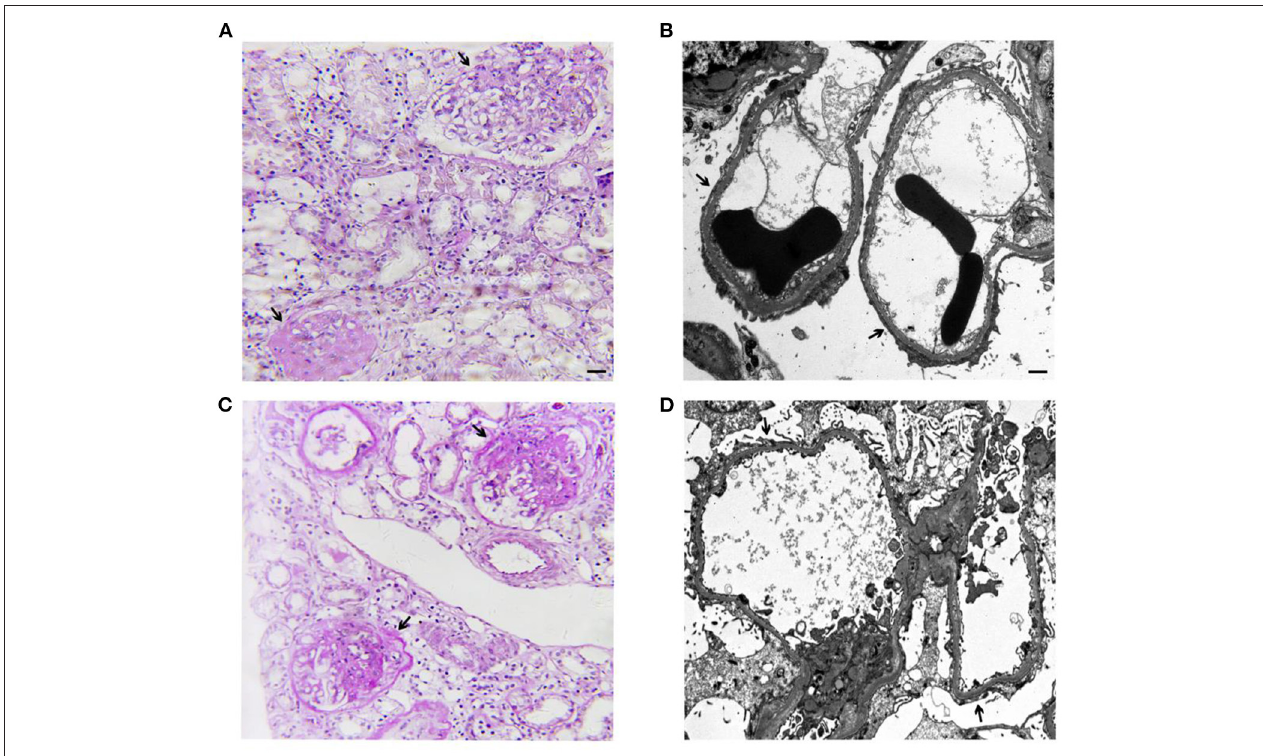
FIGURE 1 | Representative images of light microscopy and transmission electron microscopy (TEM) from the kidney biopsies of the elder sister at age 12 (A,B) and the younger brother at age 8 (C,D) . (A) Global or segmental glomerulosclerosis (arrow) in 23 of 38 glomeruli (Periodic Acid-Schiff staining. Scale bar: 50 µ m). Immunofluorescence microscopy revealed negative for IgG, IgA, IgM, C3, C1q, kappa light chain, and lambda light chain in 2 glomeruli. (B) Representative TEM showed diffuse foot process effacement of the podocyte (arrow), partial irregularity of the glomerular basement membrane, foam cells, and no subendothelial and mesangial dense deposits (Scale bar: 1 µ m). (C) Global or segmental glomerulosclerosis (arrow) in 7 of 33 glomeruli (Periodic Acid-Schiff staining. Scale bar: 50 µ m). Immunofluorescence microscopy revealed mesangial IgM deposits ( ++ ) negative and negative results for IgG, IgA, C3, C1q, kappa light chain, and lambda light chain in 2 glomeruli. (D) Representative TEM showed diffuse foot process effacement of the podocyte (arrow), partial irregularity of the glomerular basement membrane, foam cells, and no subendothelial and mesangial dense deposits (Scale bar: 1 µ